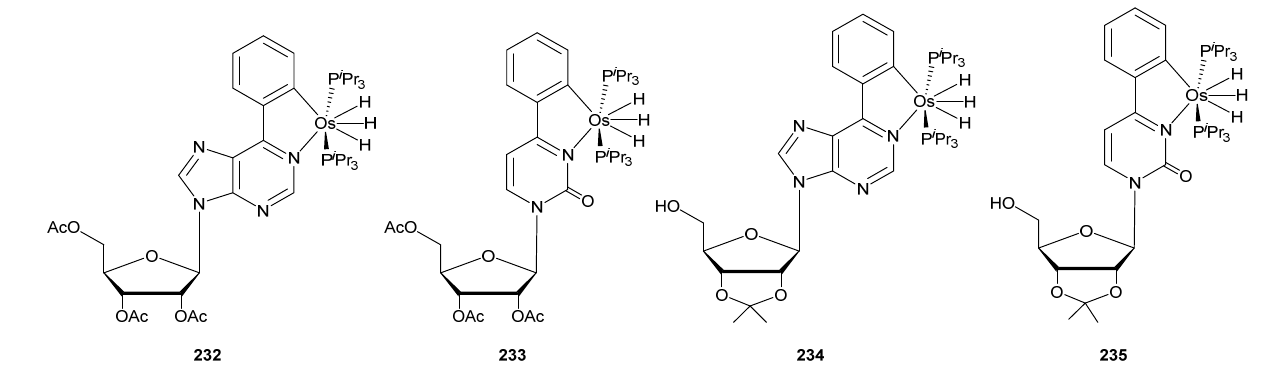
Figure 58. Osmium complexes using nucleosides as cyclometalating ligands.